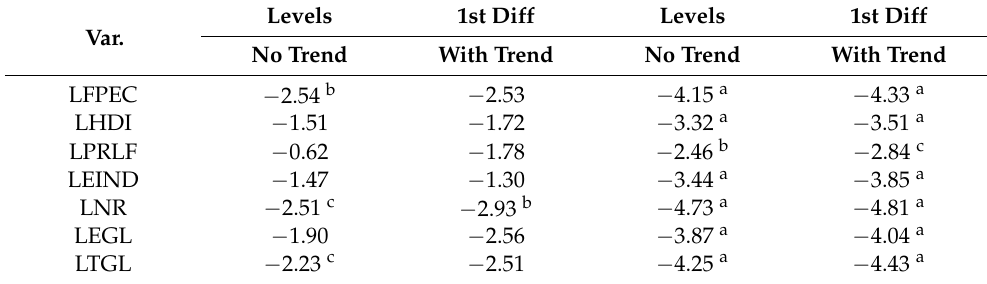
Table 4. CIPS unit root tests.